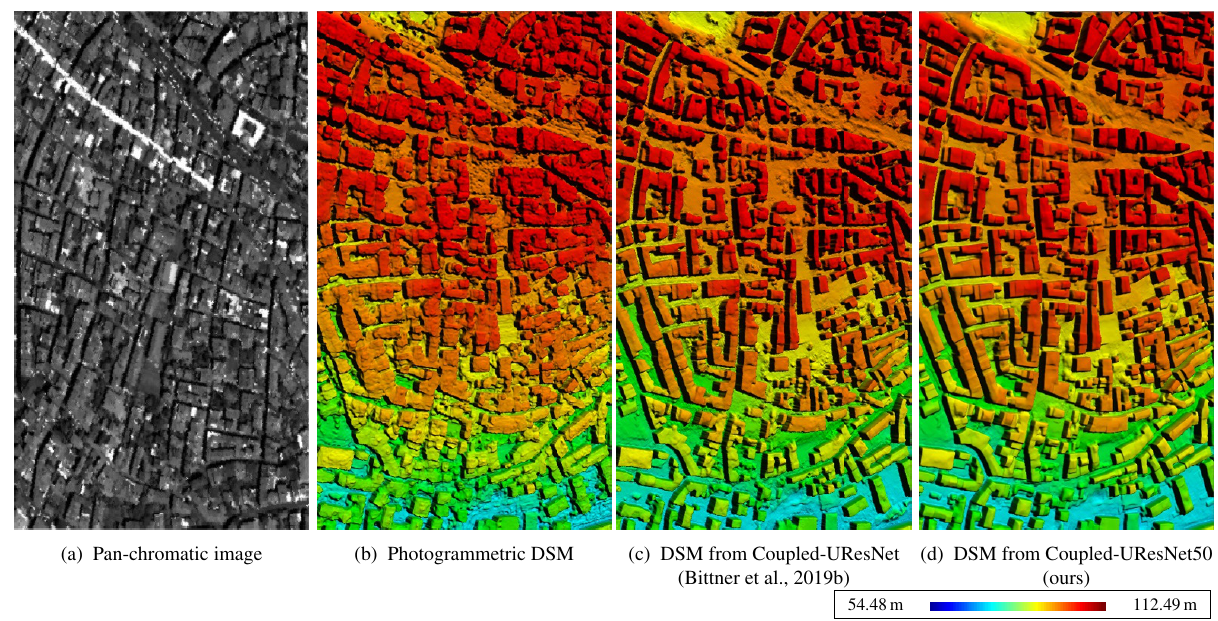
Figure 7. Visual analysis of DSMs, generated by (c) Coupled-UNet cLSGAN with fixed balancing hyper-parameters (Bittner et al., 2019b) and (d) the proposed Coupled-UResNet50 over Istanbul city, Turkey. (a) and (b) depict the initial PAN and DSM images, respectively. DSM images are color-shaded for better